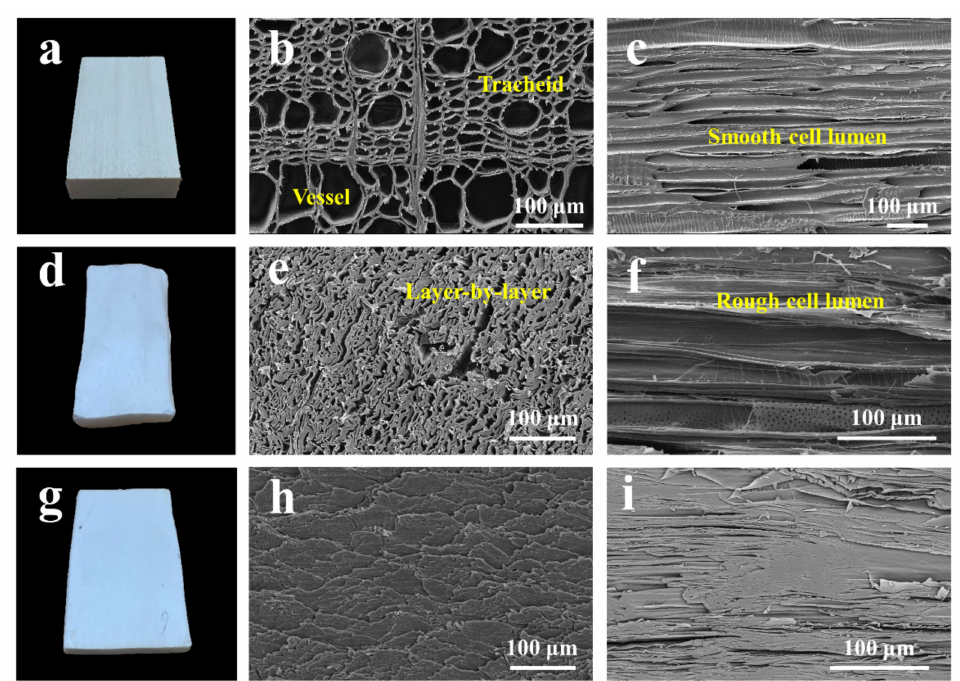
Figure 3. Photographs of ( a ) NW, ( d ) CS AD and ( g ) CS AD-ANF . Transverse SEM images of ( b ) NW, ( e ) CS AD and ( h ) CCS AD-ANF . Longitudinal SEM images of ( c ) NW, ( f ) CS AD and ( i ) CCS AD-ANF . The mechanical properties of NW, CS AD and CCS AD-ANF are presented in Figure